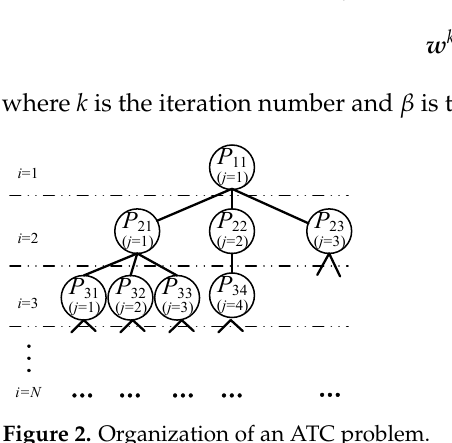
Figure 2. Organization of an ATC problem.